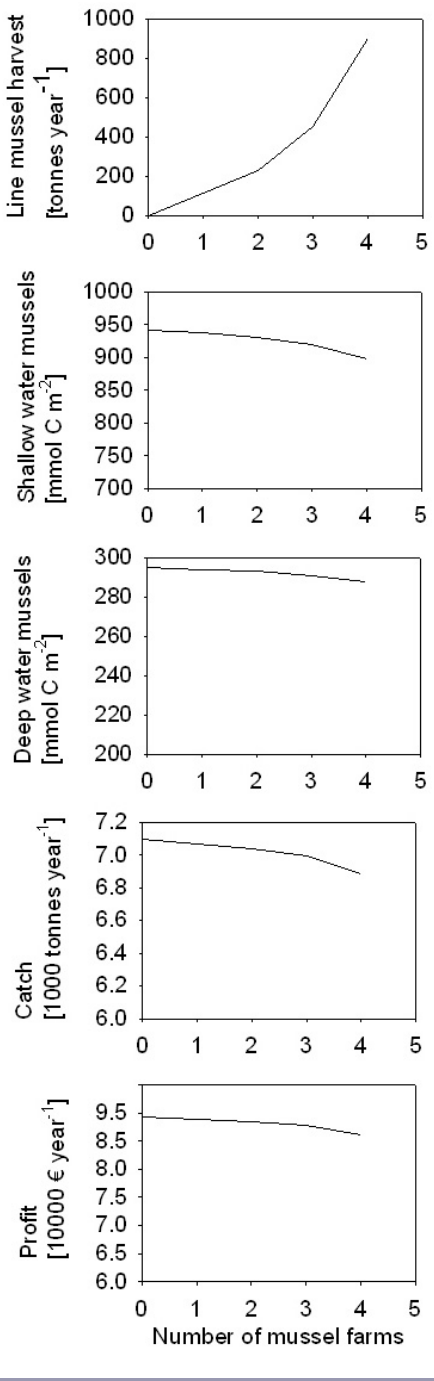
Fig. 7. Results of model simulation for Scenario 3. Impact of line-mussel culture deployment on (from top to bottom) harvested line-mussel biomass, biomass of shallow and deep-water mussels, mussel fishery landings and mussel fishery profits. The baseline is zero line-mussel cultures.